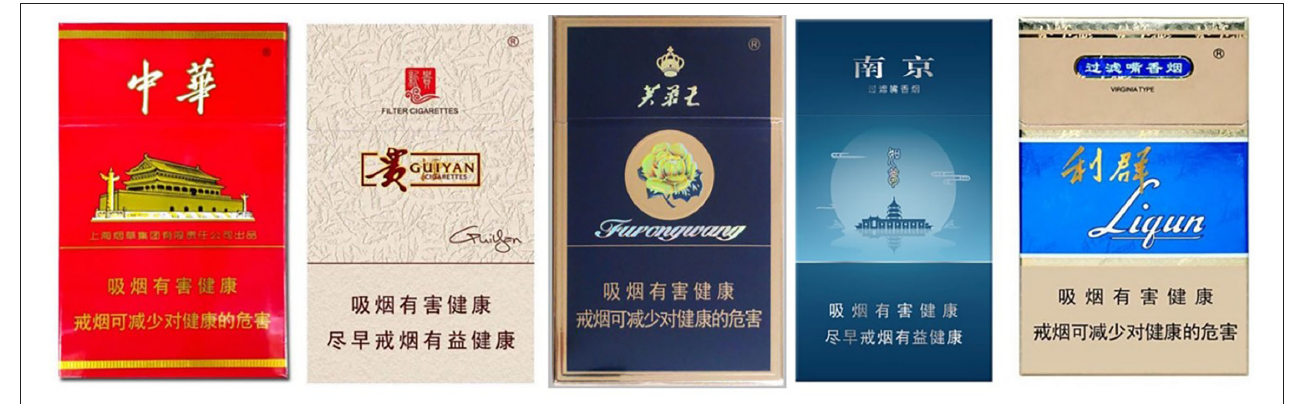
FIGURE 4 | Some common cigarette packages in the Chinese